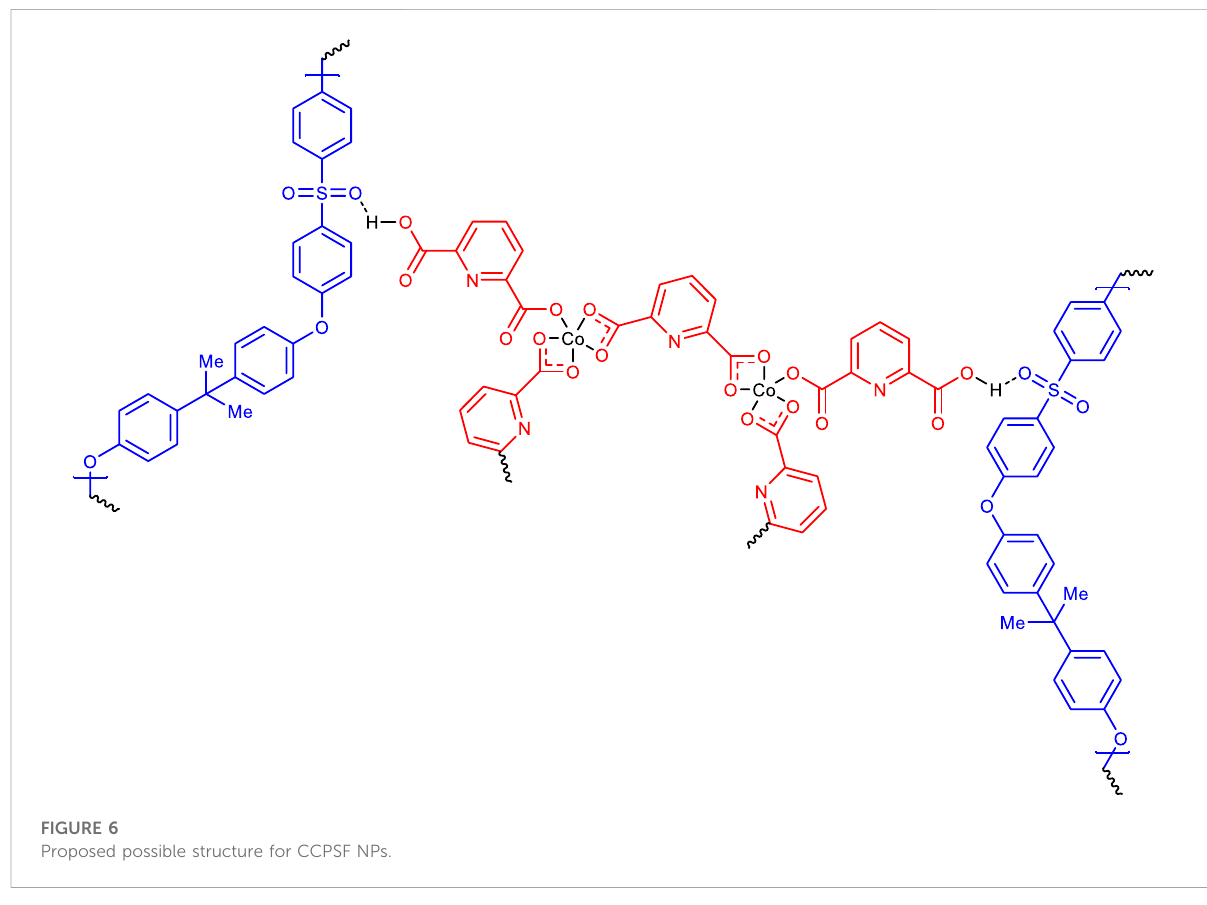
FIGURE 6 Proposed possible structure for CCPSF NPs.